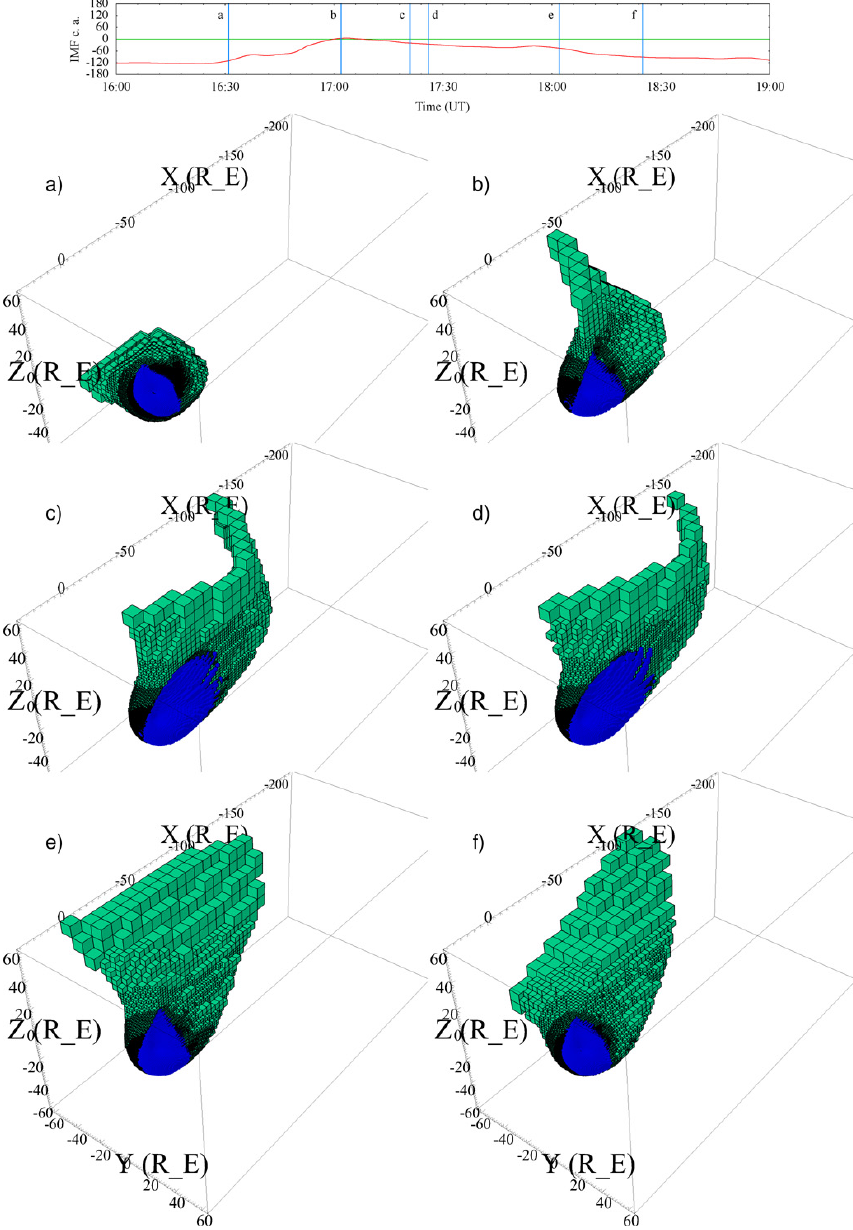
Fig. 8. Classification of cells in the simulation by their magnetic field topology is shown color coded. Blue cells show the region of closed magnetic field lines. Green cells show the region of southern lobe field lines. Northern lobe and IMF field line regions are not shown. The magnetic field topology in the simulation is shown during and after the first AE intencification at (a) 16:31, (b) 17:02, (c) 17:21, (d) 17:26, (e) 18:02 and (f) 18:25UT. The IMF clock angle in each of the sub-panels is marked by blue bars at the top of the